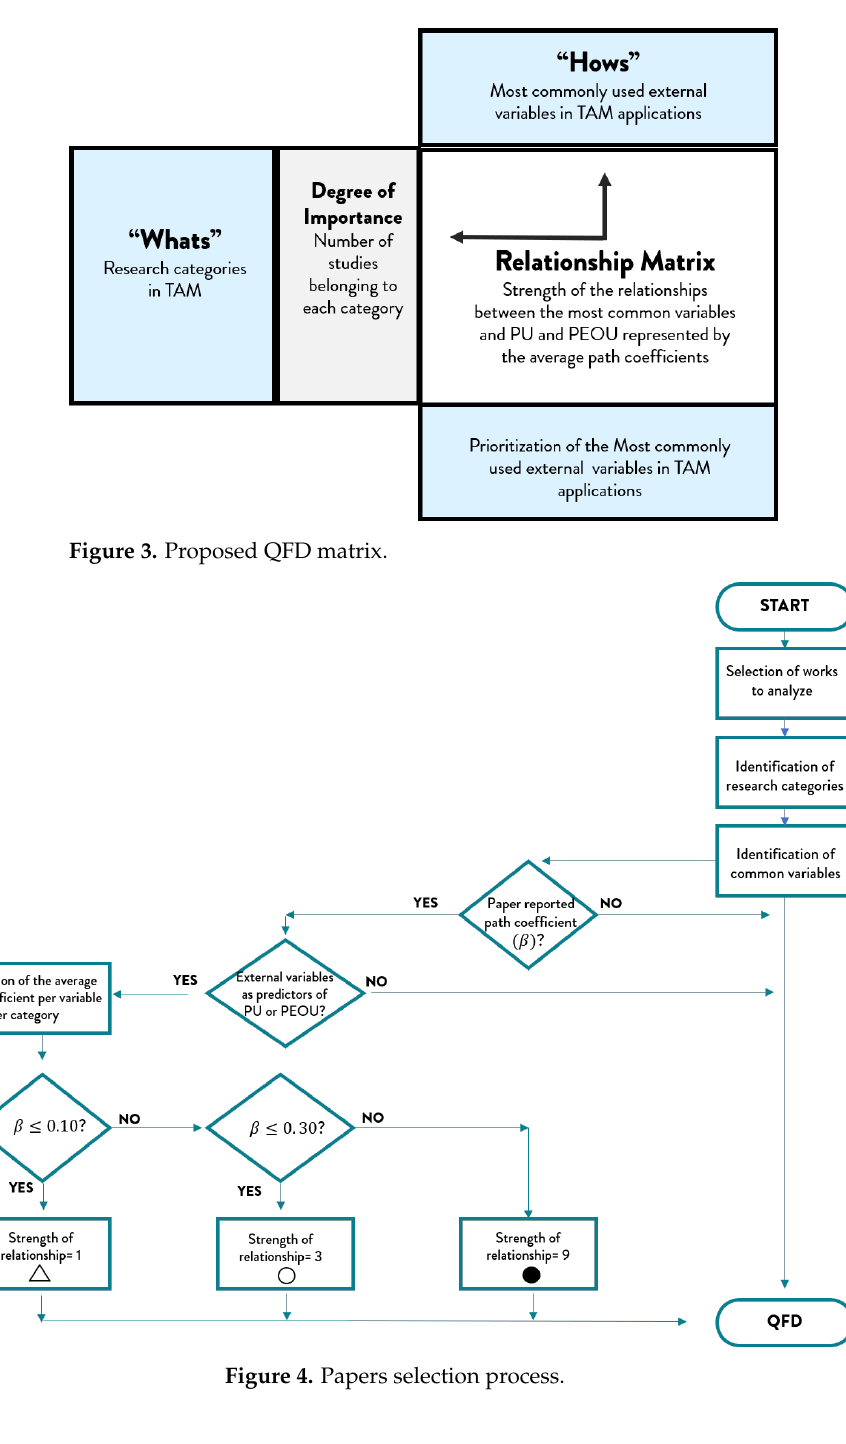
Figure 4. Papers selection